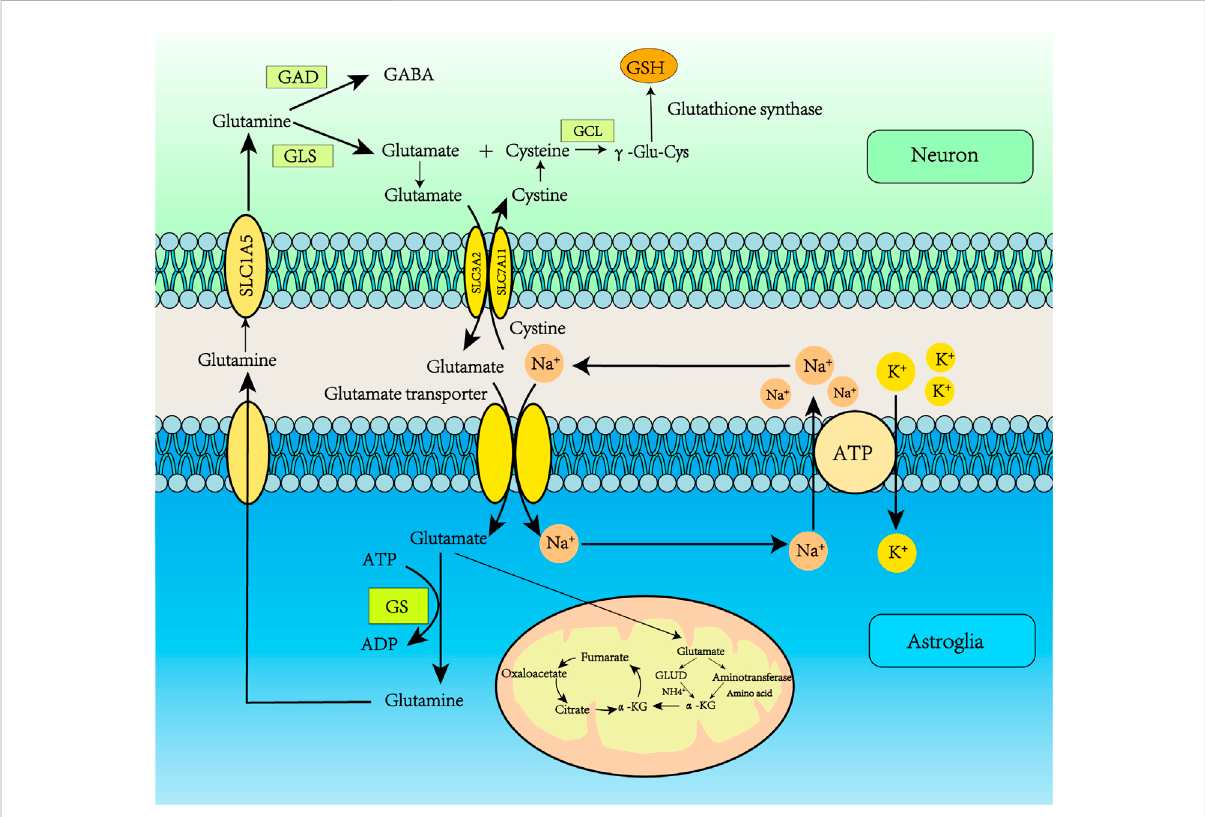
Glutamate recycling via the glutamate-glutamine cycle. Glu transporters are mainly distributed in astrocyte synapses. Glu binds to transporters which deliver it to the astrocyte cytoplasm. Glu transporters are co-transported into astrocytes by Na + and Glu, and Na + is transported to the extracellular space by Na + /K + -ATPase. Glu reacts with GS to produce Gln, and the ATP consumed in this process may be supplied by glycolysis. The resulting Gln is released into the neuron, and then Gln enters the neuron through the SLC1A5 receptor. The Gln absorbed by the neuron is converted into Glu under the action of glutaminase. GABA can also be produced by the action of Glu decarboxylase. In addition, Glu can be converted to α -ketoglutarate by Glu dehydrogenase or aminotransferase, participating in the tricarboxylic acid (TCA) cycle, which provides citrate and oxaloacetate for lipid synthesis and converts Glu to